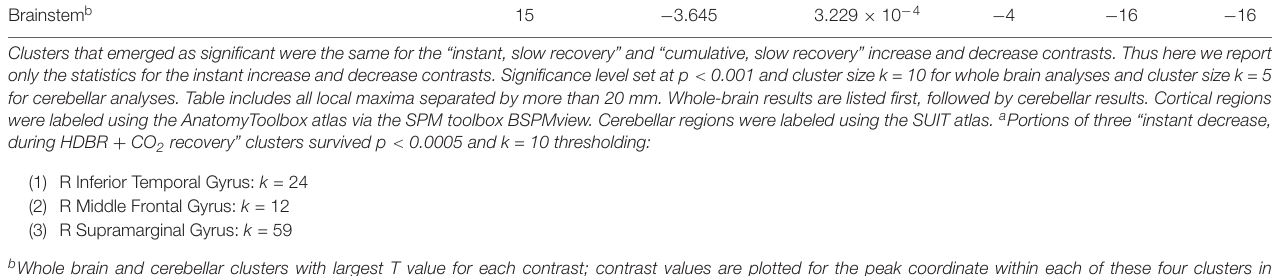
Clusters that emerged as significant were the same for the “instant, slow recovery” and “cumulative, slow recovery” increase and decrease contrasts. Thus here we report only the statistics for the instant increase and decrease contrasts. Significance level set at p < 0.001 and cluster size k = 10 for whole brain analyses and cluster size k = 5 for cerebellar analyses. Table includes all local maxima separated by more than 20 mm. Whole-brain results are listed first, followed by cerebellar results. Cortical regions were labeled using the AnatomyToolbox atlas via the SPM toolbox BSPMview. Cerebellar regions were labeled using the SUIT atlas. a Portions of three “instant decrease, during HDBR + CO 2 recovery” clusters survived p < 0.0005 and k = 10